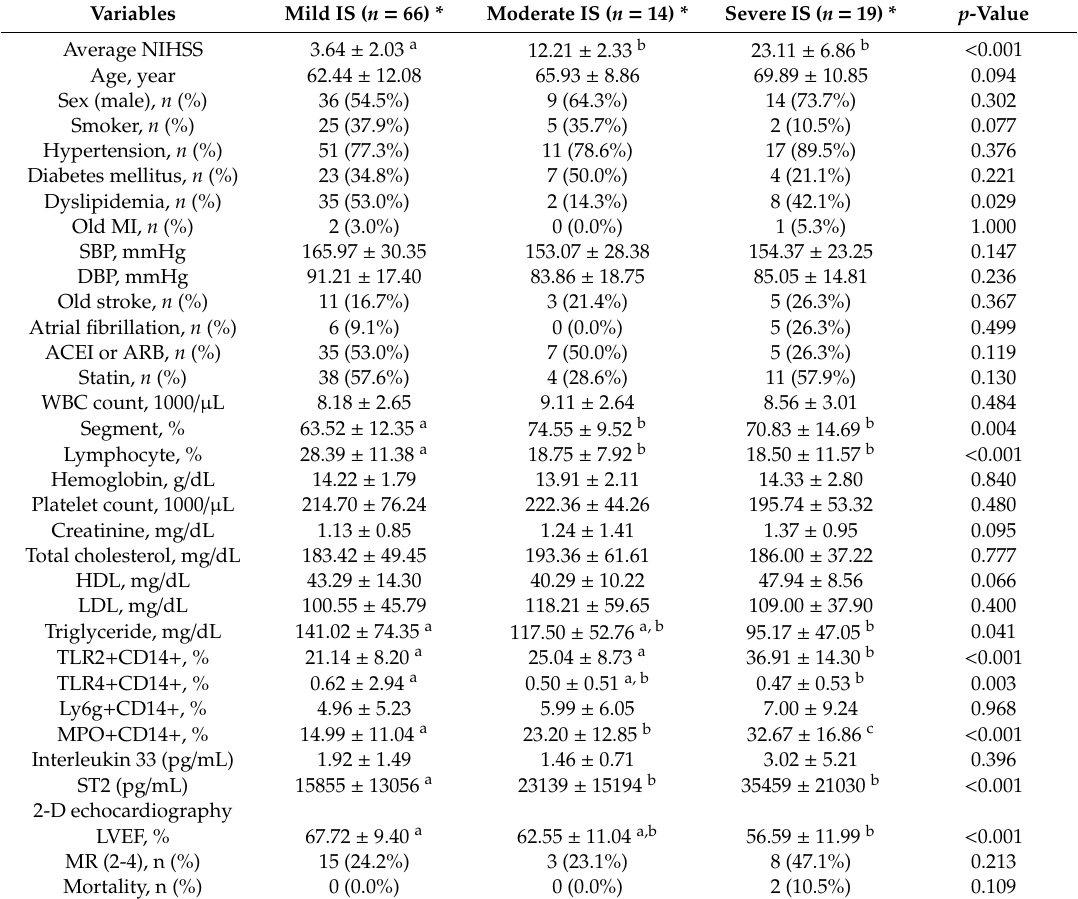
Table 1. Baseline characteristics of three groups with di ff erent severities of acute ischemic stroke